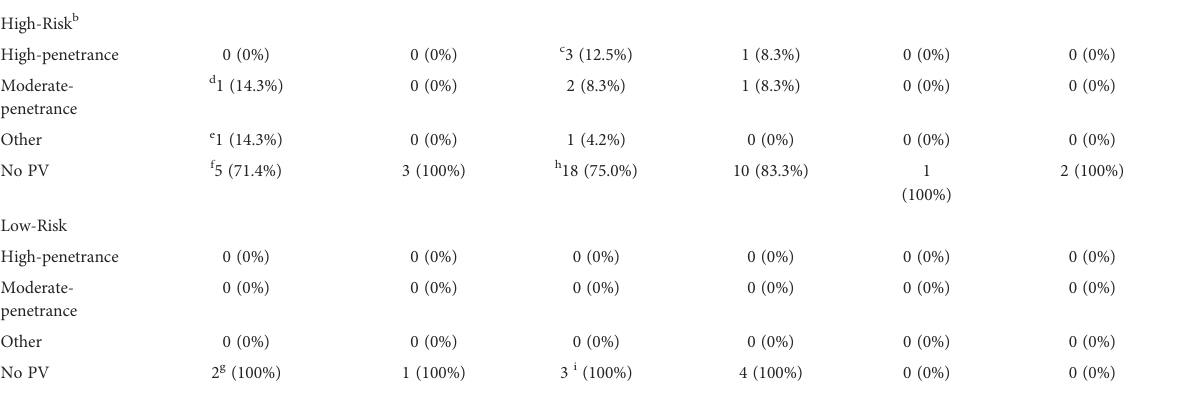
TABLE 4 Risk-status and germline variants in 59 women with second cancer